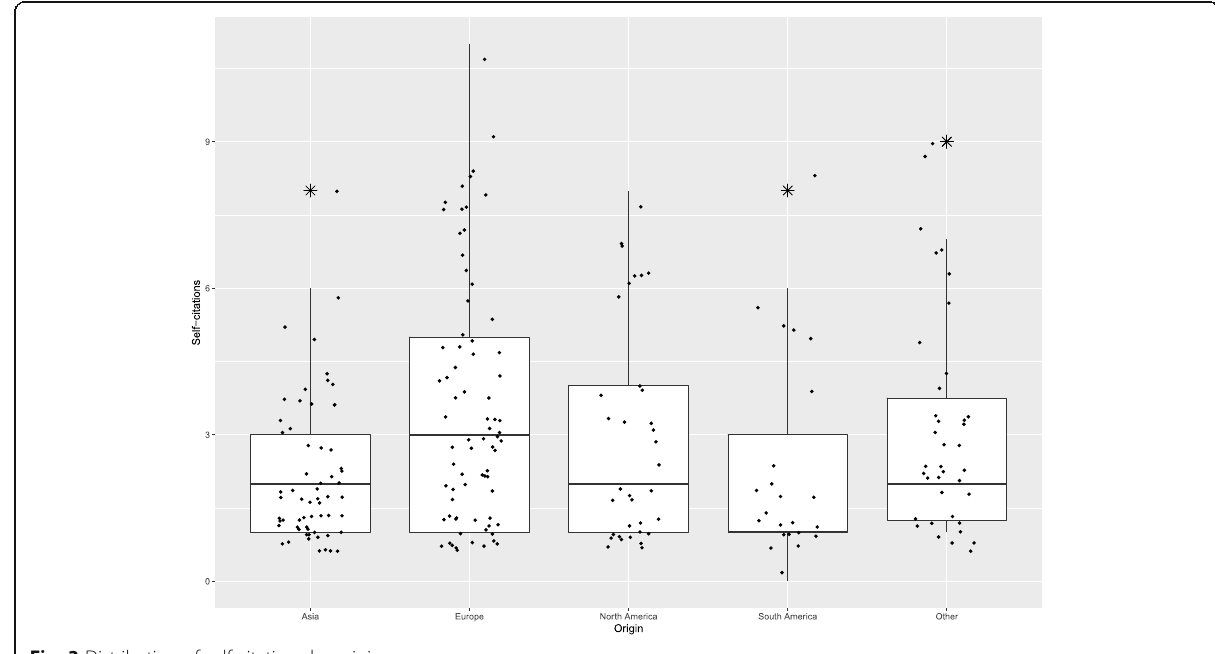
Fig. 3 Distribution of self-citations by